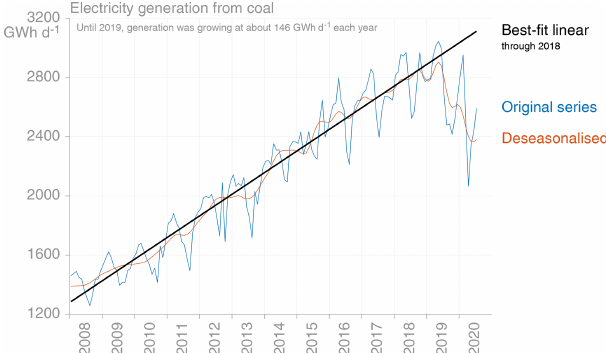
Figure 4. India’s hard-coal demand. Filled circles and hollow cir- cles show reported and projected demand in two five-year plans, while the light blue line shows actual demand, and annual growth rates are indicated. Demand does not equal consumption because of changes in stocks at power stations and industry. Source: Ministry of Coal (2006, 2011), own calculations.